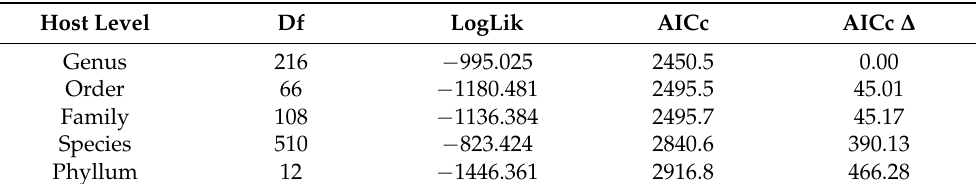
Figure 3. Species accumulation curves of host tree species for individual Ganoderma species created with method “collector” adding the years in the order they happen to be in the data. Table 1. Comparison of GLM models with presence of given Ganoderma species as dependent variable and varying resolution of host identity as explanatory variable. Host level: taxonomic level of host used as explanatory variable; Df: degrees of freedom used in the model; LogLik: log-likelihood; AICc: the value of the Akaike information criterion; AICc ∆ : difference in information criterion between the model and the best model with lowest AICc.